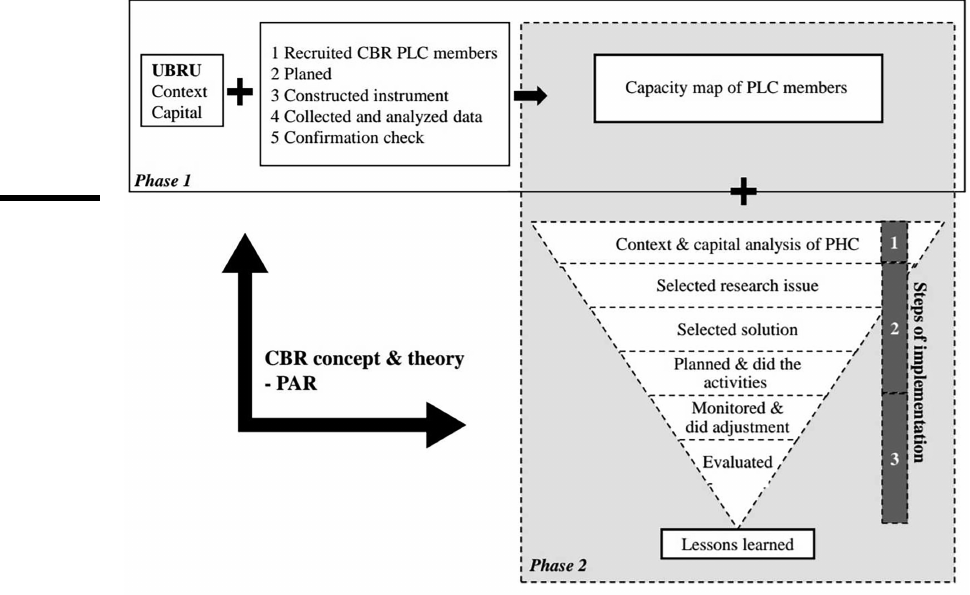
Figure 1. Conceptual